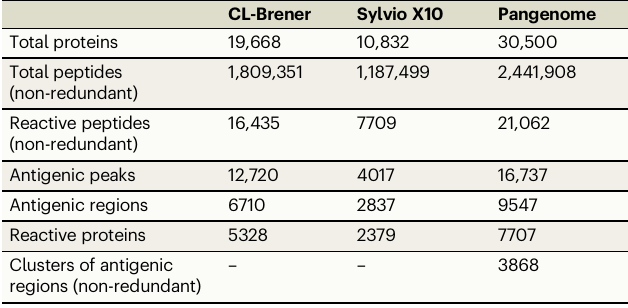
Table 1 | Discovery screening fi nding summary